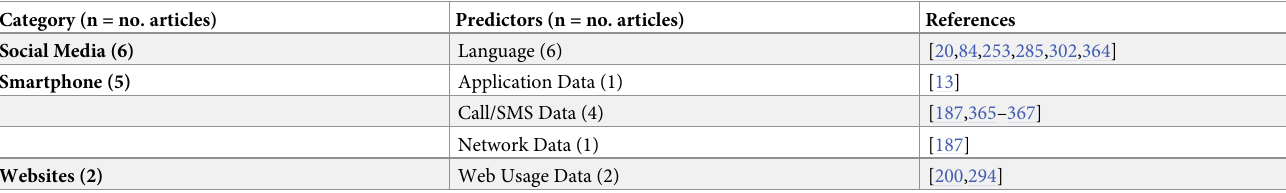
Table 18. Number of articles predicting income, with associated predictors and references. Category (n = no. articles)